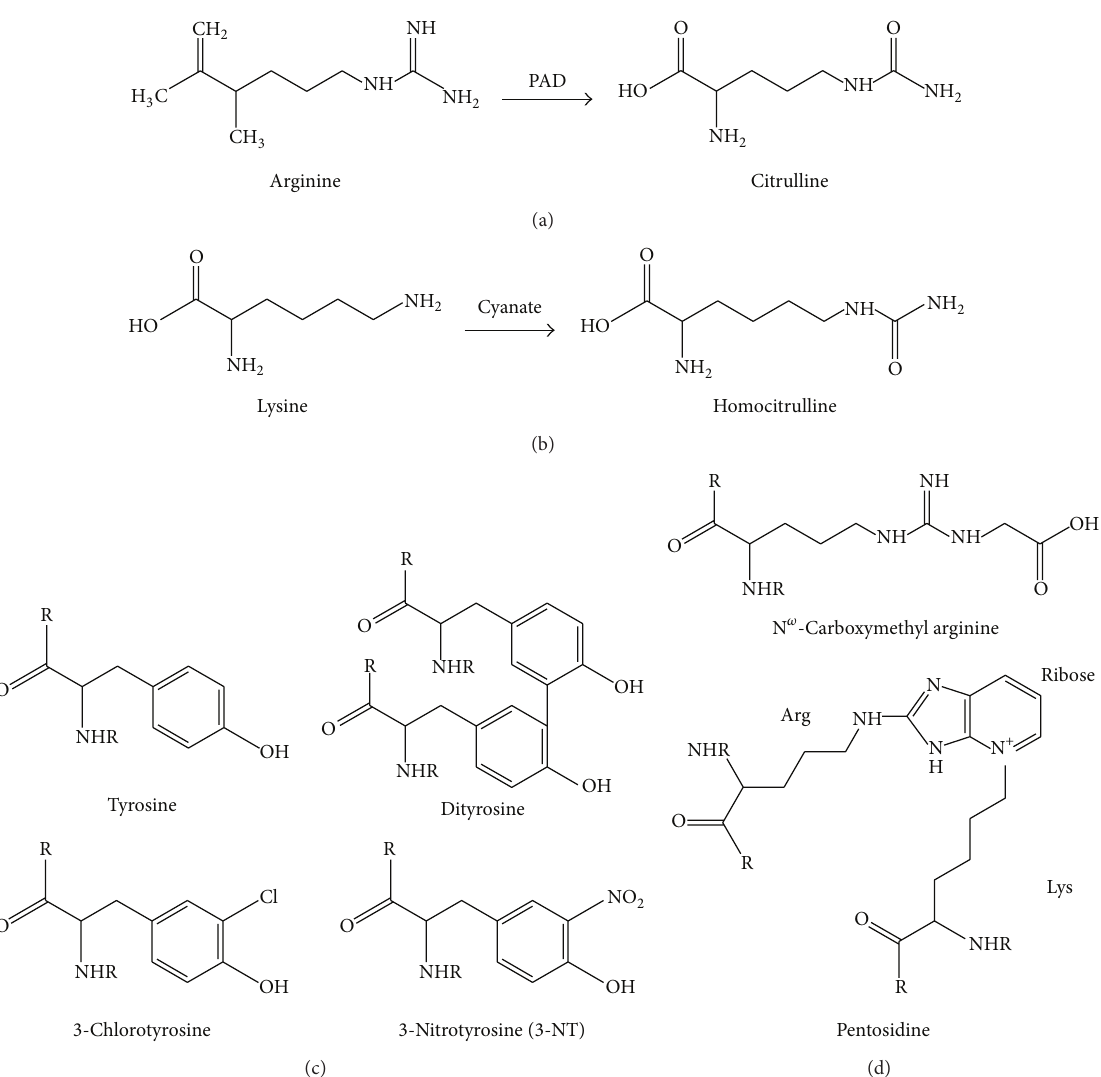
Figure 1: (a) Enzymatic generation of citrulline from arginine catalyzed by peptidylarginine deiminase (PAD); (b) non-enzymatic formation of homocitrulline by carbamylation of lysine by cyanate; (c) products of reactions between tyrosine with reactive oxygen species (forming dityrosine), reactive nitrogen species (forming 3-nitrotyrosine) and reactive chlorine species forming 3-chlorotyrosine; (d) examples of AGEs formed including carboxymethyl arginine and pentosidine (formed between an arginine and lysine